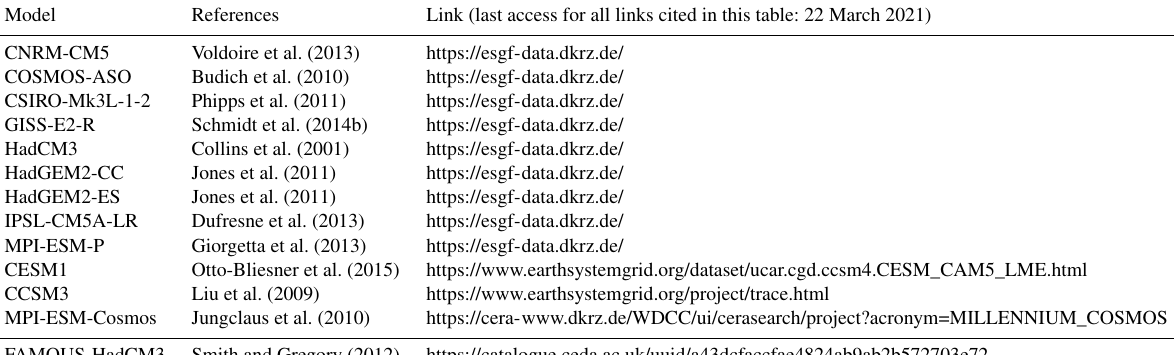
Table A2. Additional information about the pool of simulation data: model name, main reference, and link to the provider of the data. For additional information, see Table